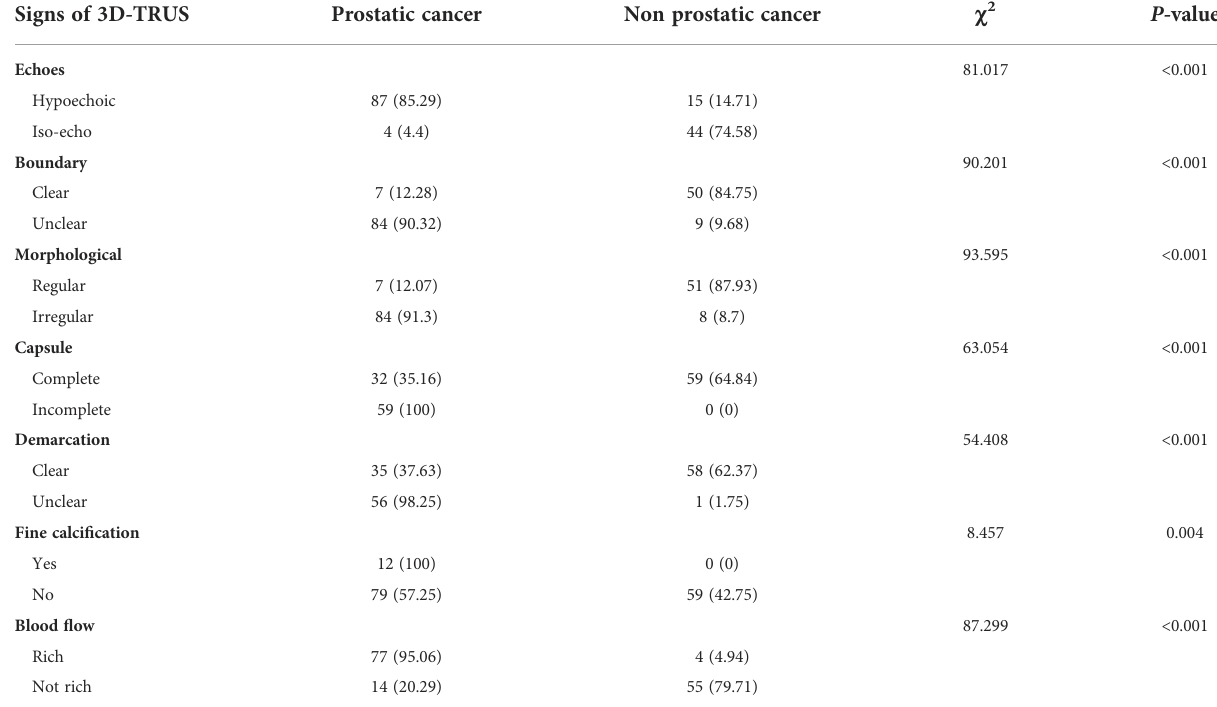
TABLE 2 The relationship of signs of 3D-TRUS and detection